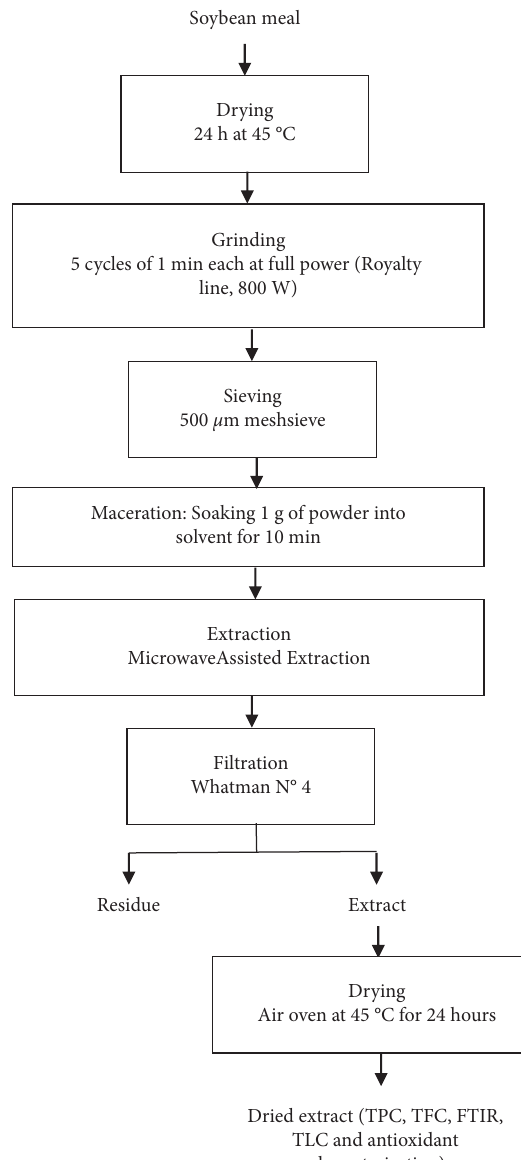
Figure 1: Extraction flow chart of phenolic compounds from soybean meal. TPC: total phenolic content, TFC: total flavonoid content, FTIR: Fourier-transform infrared, and TLC: thin-layer